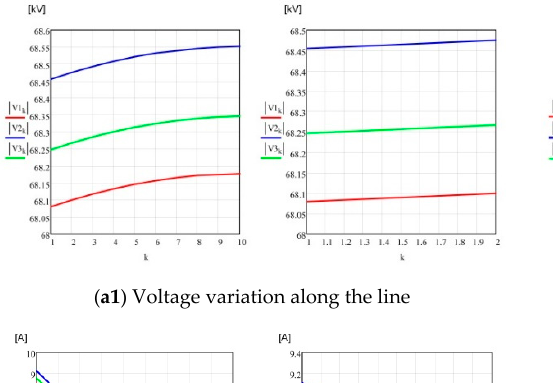
The numerical study was performed by applying the Mathcad software tool under the following